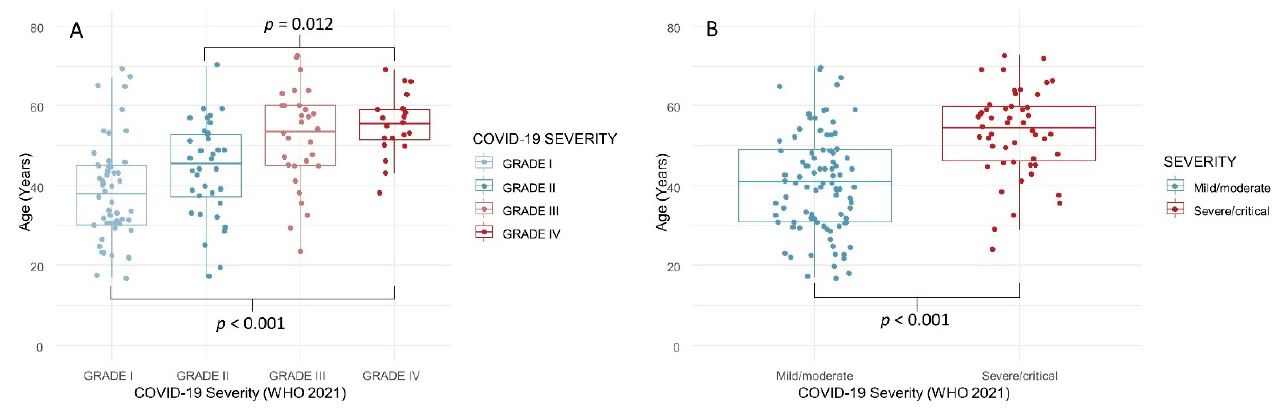
Figure 1. Age of COVID-19 survivors, according to disease severity (4 grades, ( A ); 2 grades, ( B )). BMI—Anthropometric data were available for 91 subjects (mean BMI 27.0 ± 4.4).